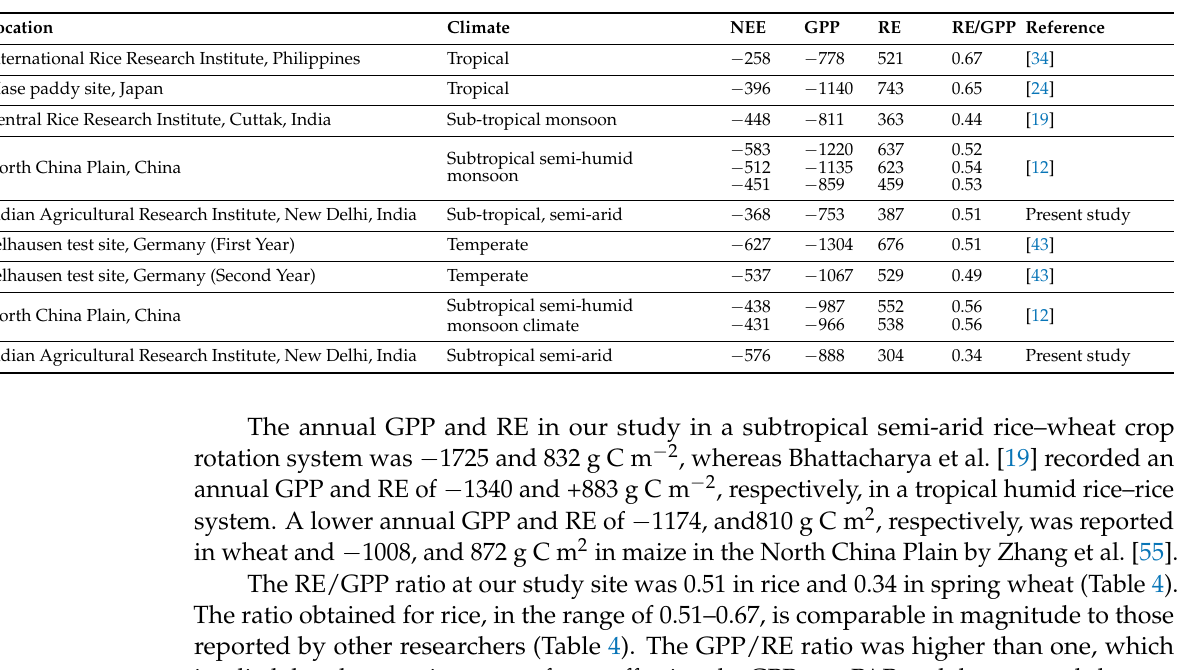
Table 4. Net ecosystem exchange (NEE), ecosystem respiration (RE) and gross primary productivity (GPP) at different rice and wheat